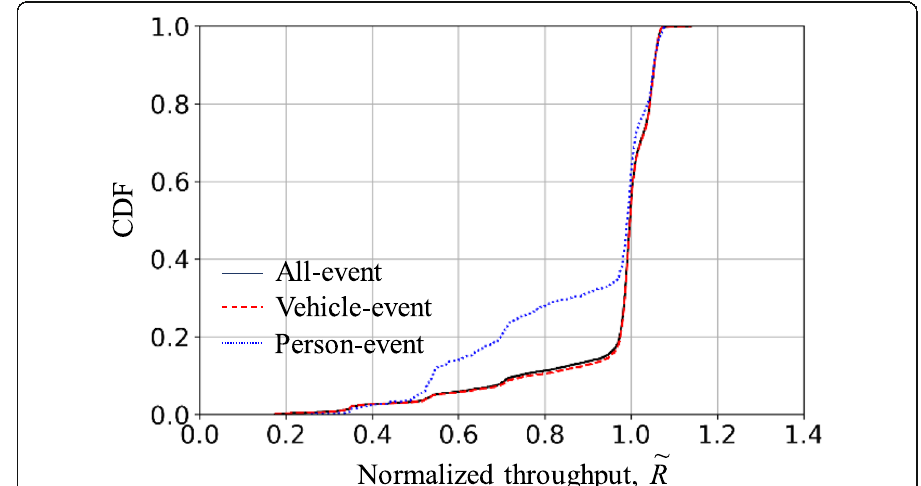
Fig. 7 CDFs of the normalized throughputs of all-event dataset, vehicle dataset, and person dataset